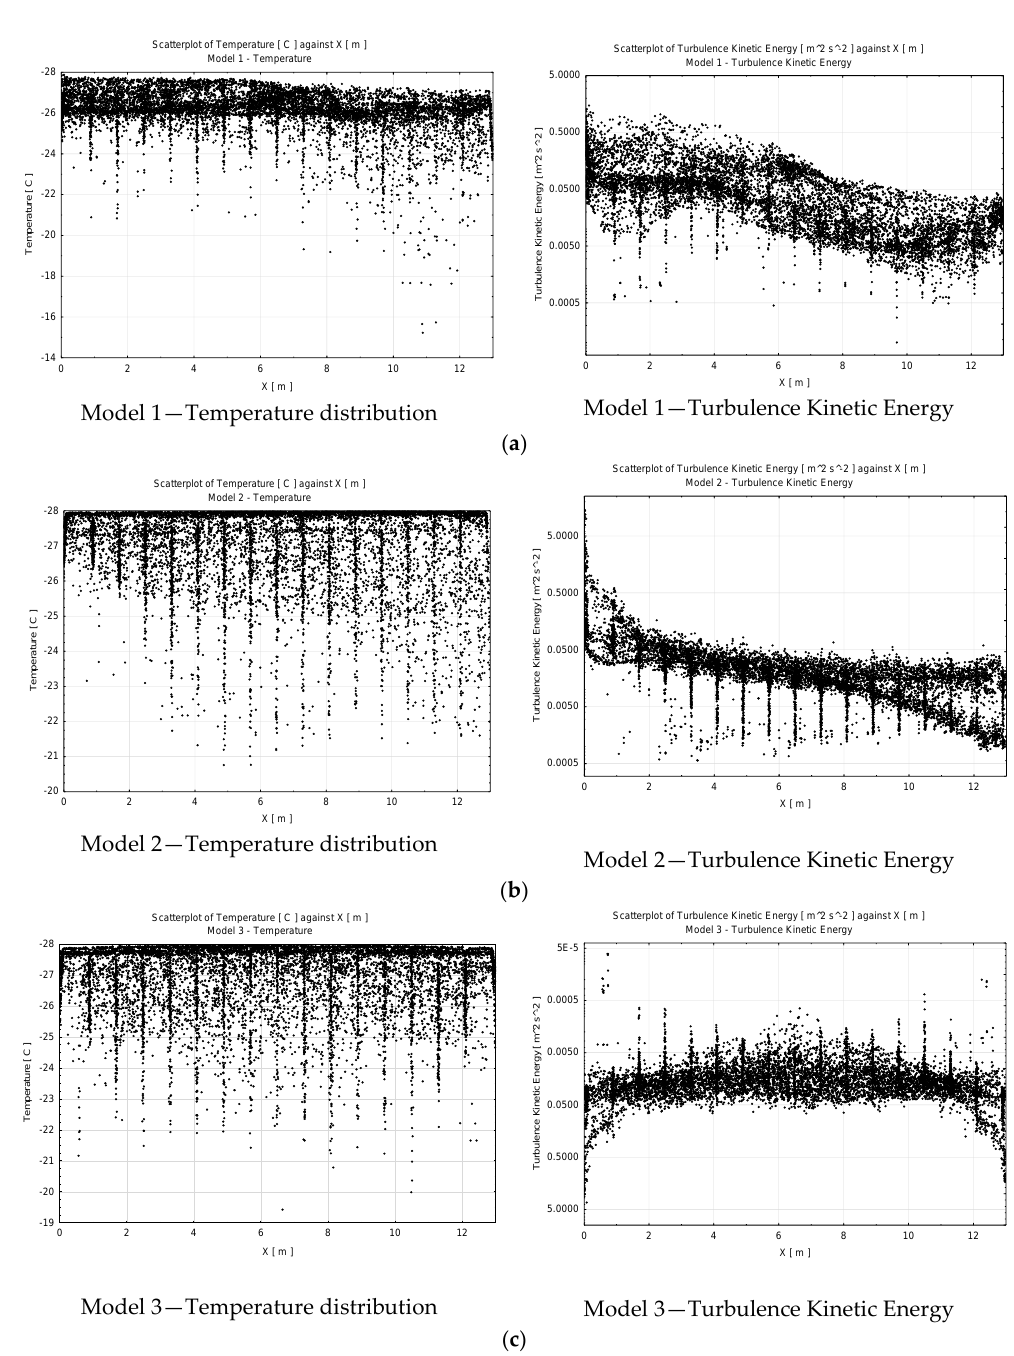
Figure 8. Temperature and turbulence kinetic energy distributions along the x axis of the trailer with sample sizes of 10,000. ( a ) Model 1: Single outlet–single inlet, ( b ) Model 2: Single outlet–multiple inlets, ( c ) Model 3: Multiple outlets–multiple